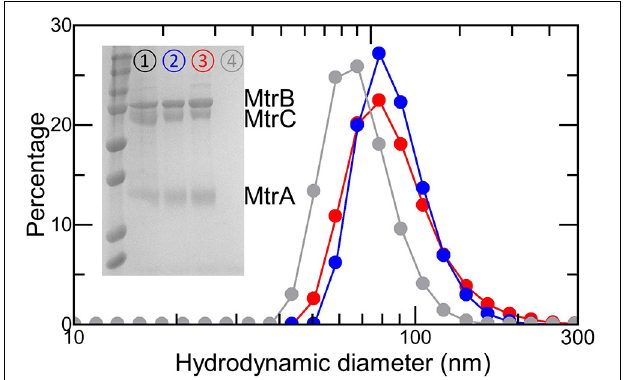
FIGURE 5 | Characterization of (proteo-) liposomes. Size analysis by dynamic light scattering of RR120-containing liposomes with Ru-MtrC:MtrAB (blue), the MTR complex (red), or no proteins (gray). Proteoliposome concentrations estimated at 6 nM in 50 mM Tris:HCl and 10 mM KCl, pH 8.5. Inset shows Coomassie-stained SDS-PAGE gel loaded with the MTR complex ( (cid:192) ); RR120-containing proteoliposomes with the MTR complex ( (cid:193) ) or Ru-MtrC:MtrAB ( (cid:194) ); and RR120-containing liposomes ( (cid:195) ). Prestained protein ladder as in Figure 2C